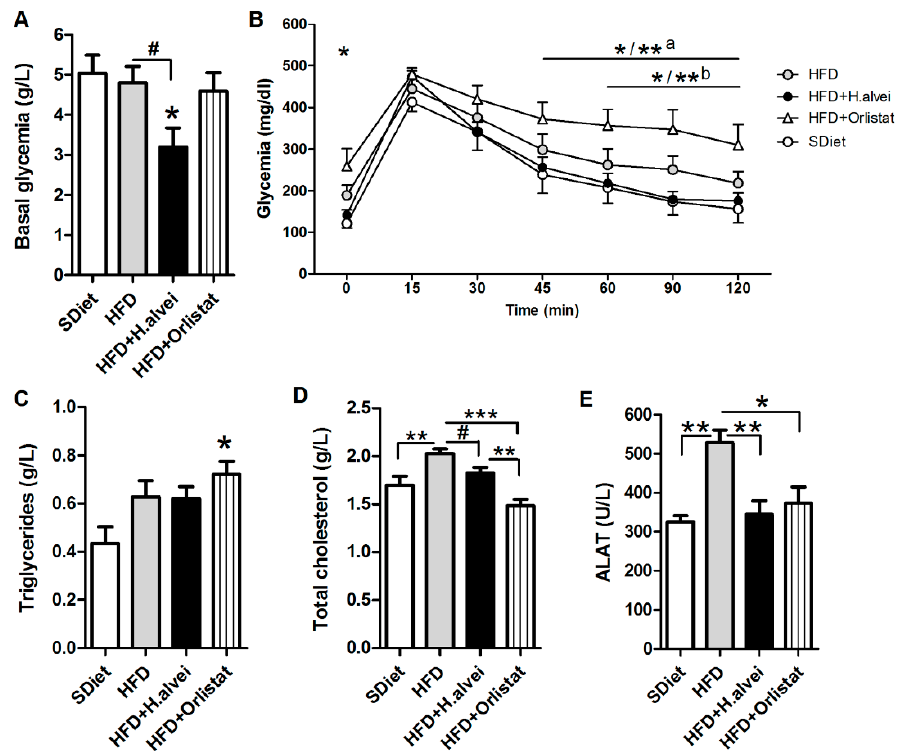
Figure 6. E ff ects of H. alvei HA4597 ™ and orlistat on glycemia and obesity-related metabolic parameters Figure 6. Effects of H. alvei HA4597™ and orlistat on glycemia and obesity-related metabolic in high-fat-diet (HFD)-fed ob / ob mice as compared to standard diet (SDiet). ( A ) Plasma glucose levels parameters in high-fat-diet (HFD)-fed ob/ob mice as compared to standard diet (SDiet). ( A ) Plasma glucose levels in ad libitum feeding conditions. ( B ) OGTT after overnight fasting. Plasma levels of ( C ) triglycerides, ( D ) total cholesterol, and ( E ) alanine aminotransferase (ALAT) in ad libitum feeding conditions. ( A ). ANOVA p < 0.05, Tukey’s posttest vs. SDiet * p < 0.05. Student’s t -test # p < 0.05. ( B )